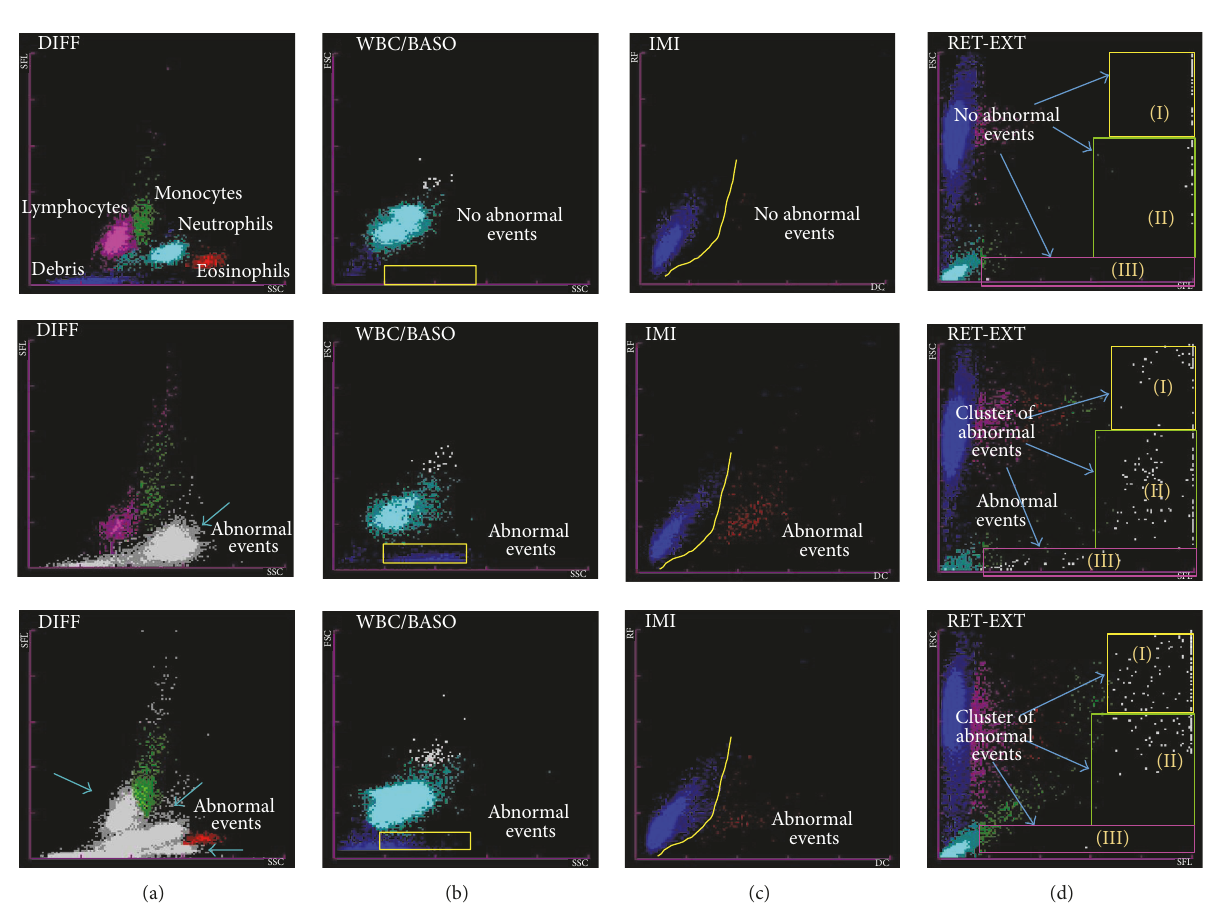
Figure 1: Parasitemia ( P. falciparum and P. vivax ) associated abnormalities in Sysmex XE2100 channels compared with normal sample at the top. (a) DIFF channel: the blue arrow indicates abnormal events depicting pseudoeosinophilia and graying of neutrophil cluster and double neutrophil and eosinophil populations; (b) WBC/BASO channel: yellow box shows parasite containing ghost RBCs; (c) IMI channel: comparatively more immature cells in area below yellow line in malaria positive cases; and (d) RET- EXT channel: presence of cluster of abnormal cells in any of the sectors extending vertically down and moving horizontally towards the 𝑦